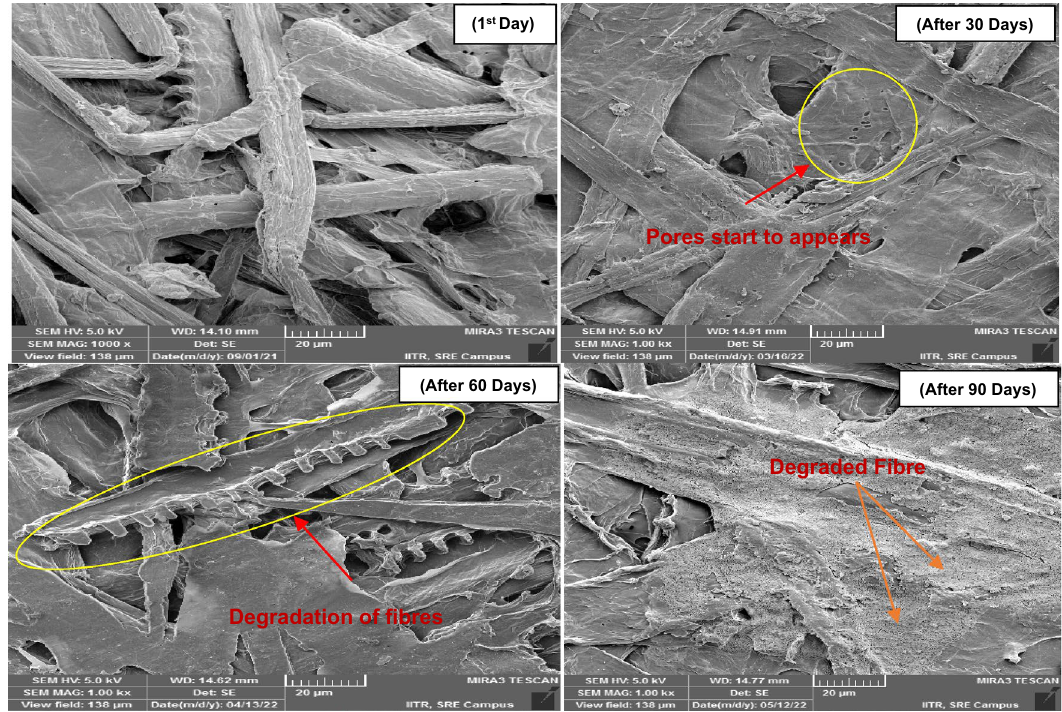
Figure 5. FE-SEM image analysis of the pulp sheet exposed to VAA.